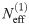
Natural and effective state of the system.N(1) and Neff(1) behave similarly, however, the effective state has a higher variance.